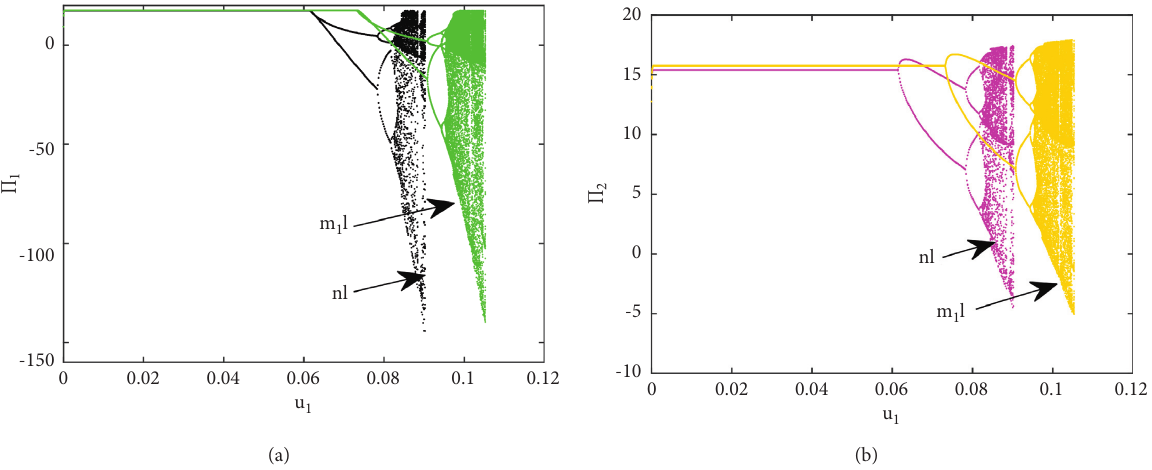
Figure 8: Bifurcation diagram of the profit with varying u